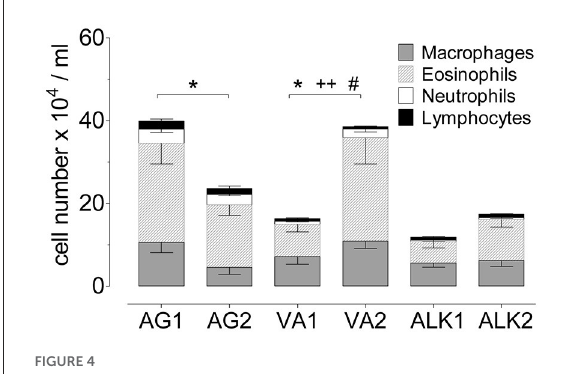
FIGURE4 Airway inflammation during the onset of acute allergic disease with diverse RWP from different geographical locations without added adjuvant over 21 days. Total number of cells in BAL with the distribution of macrophages, eosinophils, neutrophils and lymphocytes. Data are presented as mean ± SEM minus PBS control and are representative of at least two experiments; n = 8 . Asterisks show significant differences in total cell numbers: * p < 0.05, t -test. Significant differences in eosinophils: ++ p < 0.01, and in neutrophils: # p < 0.05, Mann-Whitney